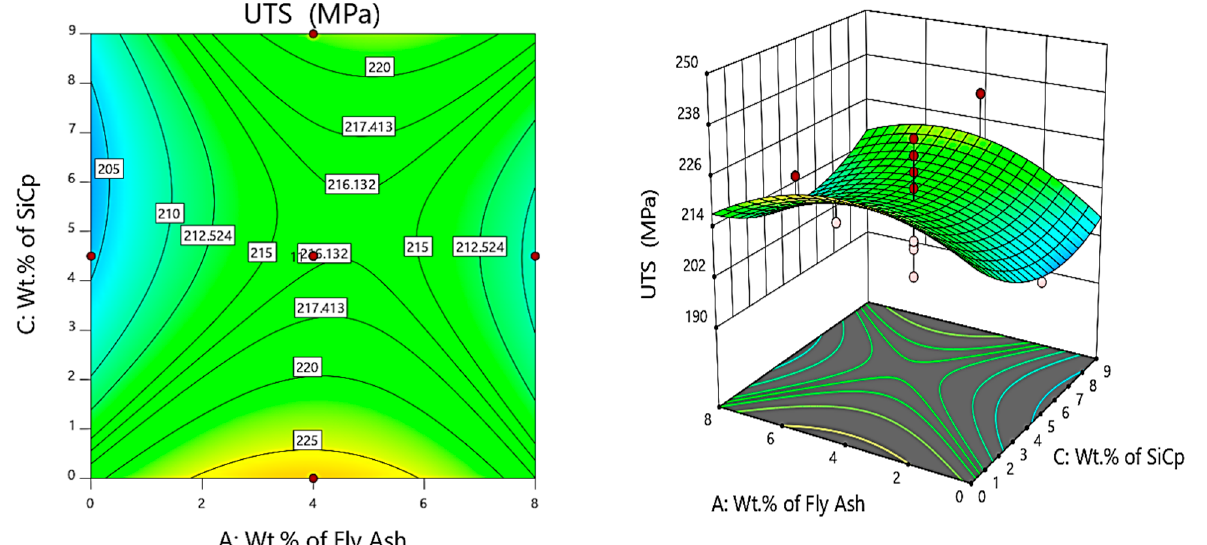
Figure 10. Contour and 3D surface plots for variation of UTS with varying wt.% of SiC and fly ash.